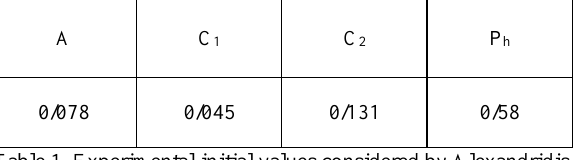
Figure 3. Map of the height changes in the study area